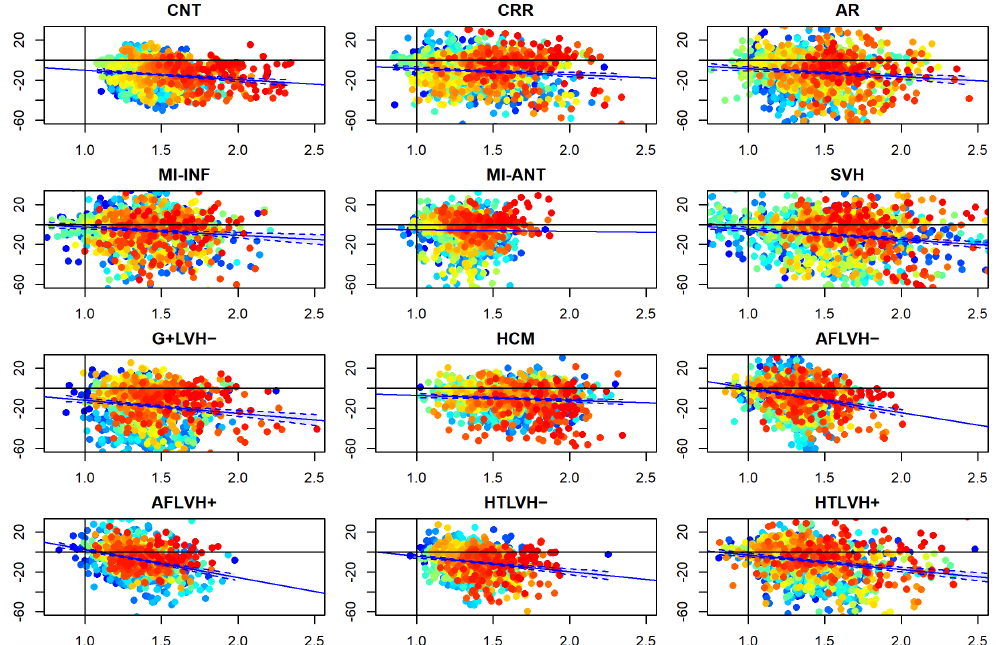
Figure 10. Relationship between Endo/Epi RMS static curvature ratio in systole (in abscissa) and Endo-Epi α p differences (per category and per-landmark median values). Blue lines represent